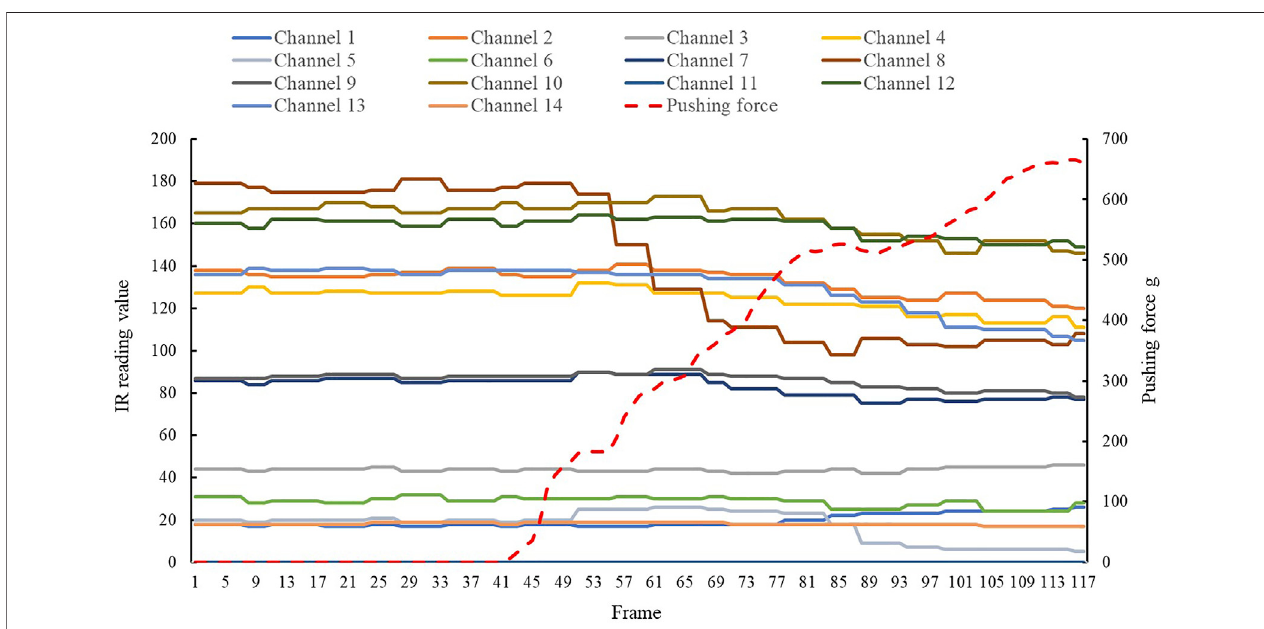
FIGURE 6 | Example of the original data on the signals read by each IR sensor and the pushing force for the middle fi nger. EMS was applied at approximately 40 frames (50 Hz), and a large amount of IR data changed afterward.